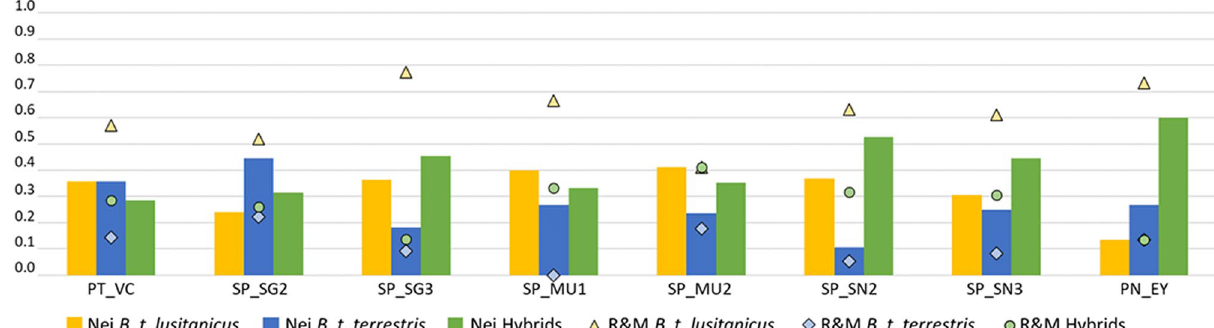
Figure 2. Distribution of highest probability subspecies or hybrid assignments of Iberian bumblebee individuals originating from each geographical location using the resampling procedure in GeneClass 2.0 by Nei’s standard distance method (Nei, bars), and by Rannala & Mountain’s Bayesian method (R&M, points).